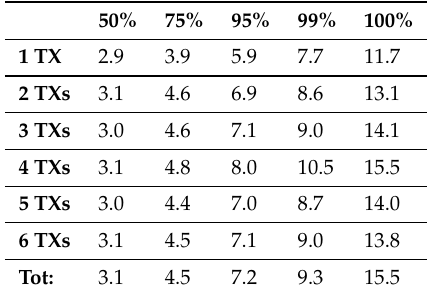
Table 3. Percentiles of σ r (mm) for all configurations.